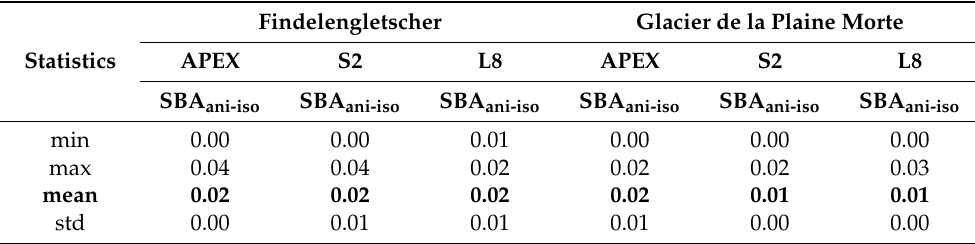
Table 4. Glacier-wide average statistic values of the impact of anisotropy correction (SBA ani minus SBA iso ) on albedo products from different datasets for Findelengletscher ( left ) and Glacier de la Plaine Morte ( right ) derived with the SBA algorithm.